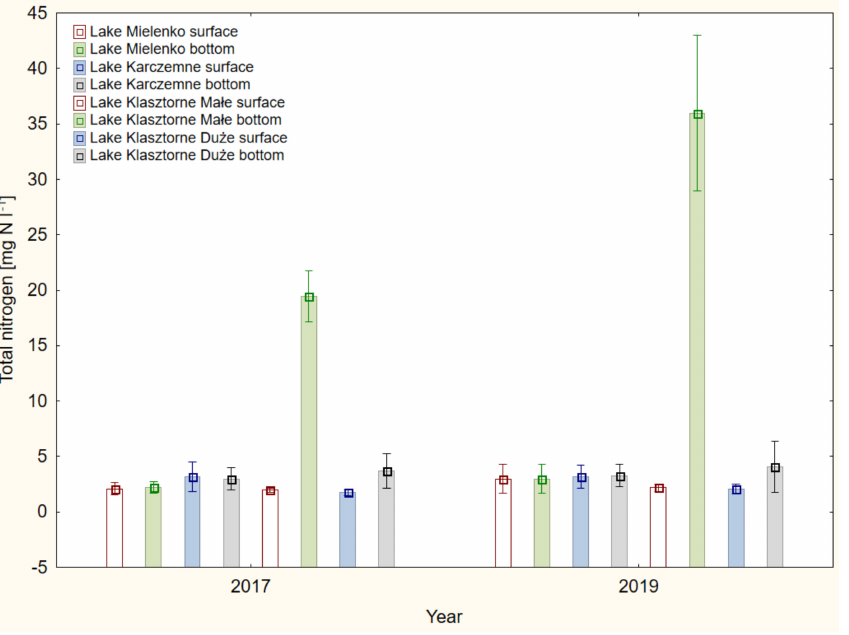
Figure 6. Mean annual values of total nitrogen (TN) in the water of Kartuzy lake complex in selected research years (box ± SEM, whisker plots ± Standard